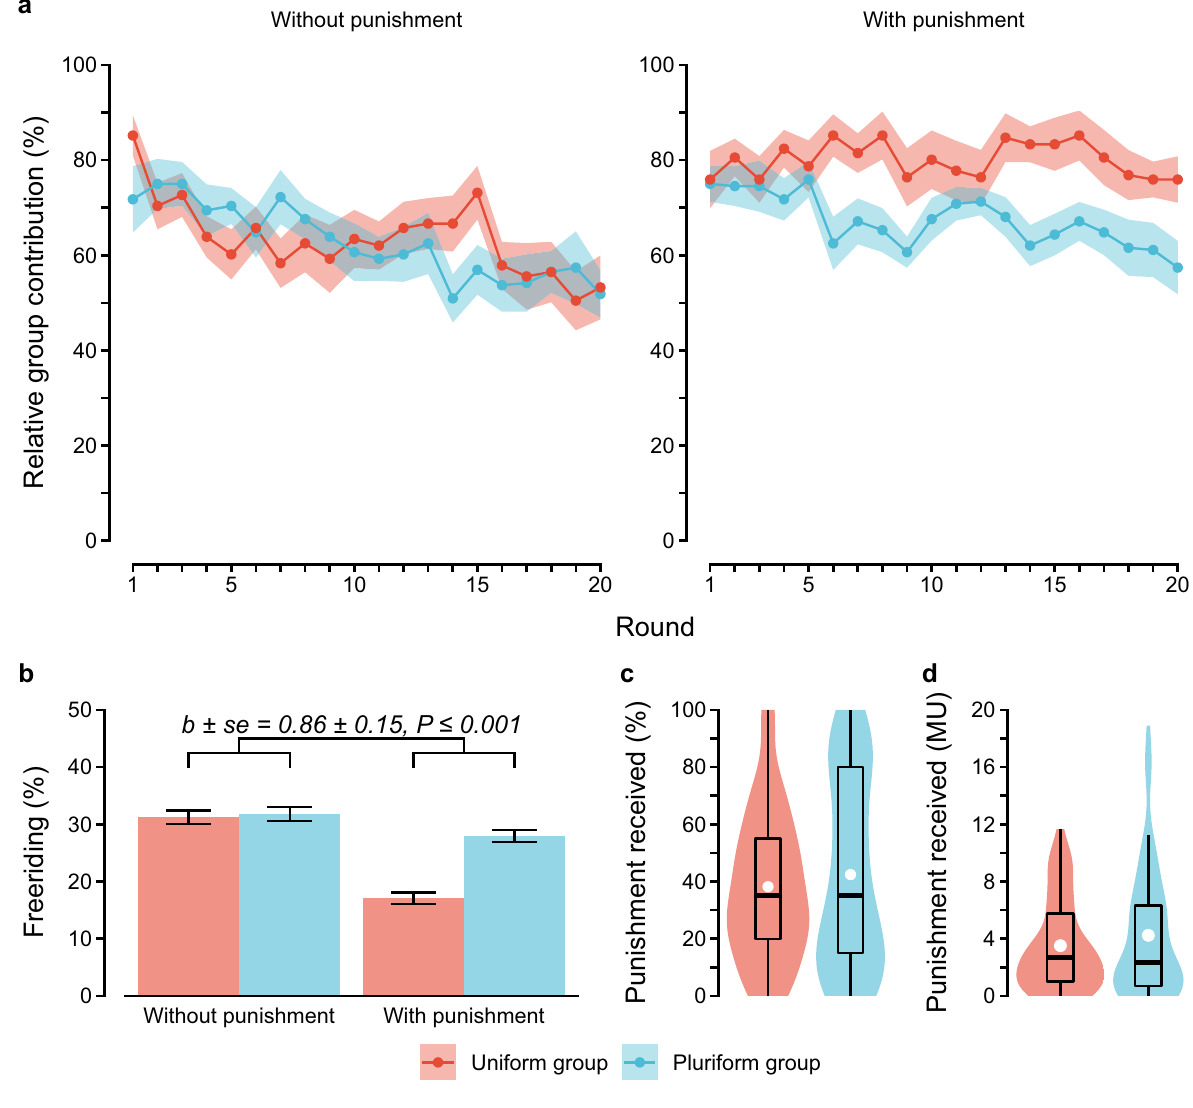
Figure 1. Effectiveness of punishment. ( a ) Mean relative group contributions over rounds as a function of punishment and group structure (100% implies that all members with an endowment in the group contributed to the public good). Bands around the mean indicate ± se . ( b ) Mean (± se ) frequency of free-riding as a function of punishment and group structure. ( c ) Violin plot of the average frequency of receiving punishment and a ( d ) violin plot of the average costs of receiving punishment (per round), as a function of group structure. White dots indicate the